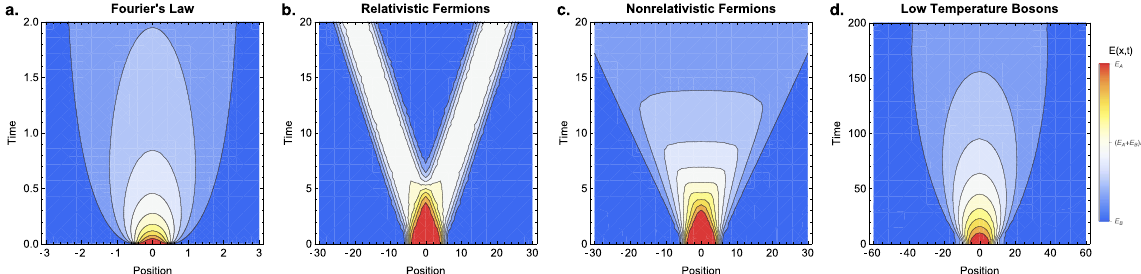
Figure 2. The energy spread of an initial subsystem A at a hot temperature T A (in red) immersed in a cold bath at T B (in blue), for four different theories, computed in d = 1. For the right three panels we performed a lattice computation with L = 200 and L A = 10, so that region A is defined as 5 < x ≤ 5. The colors represent local energy density, and interpolates linearly between E A and E B . ( a ) The classical Fourier’s law predicts a diffusive spread of the heat, here computed using the heat kernel with region A defined as | x | < 0.5. The temperature difference in subsystem A vanishes diffusively according to Δ T ( t ) ~ t − 1/2 . ( b ) For relativistic fermion systems ( T A = 2, T B = 1, n = 0.5) there is instantaneous thermalization once A is in complete causal contact with the bath. ( c ) In non-relativistic fermion systems ( T A = 2, T B = 1, n = 0.5) there is ballistic transport of particles, however, since not all particles have the same speed there is a power-law decay of the initial temperature difference, following Δ T ( t ) ~ t − 1 . ( d ) Non-relativistic boson systems display a crossover from ballistic to diffusive thermalization. Here we show the energy profile in the low temperature regime where diffusive behavior is visible, T A = 100, T B = 0.2 and n = 0.5.